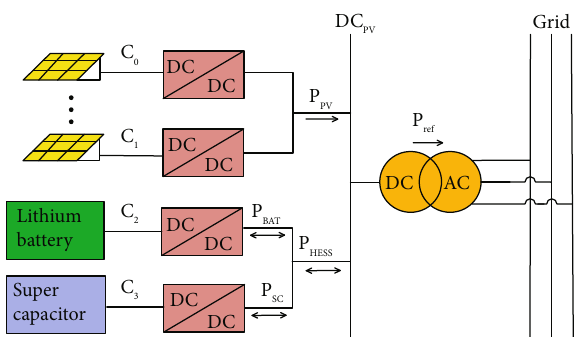
Figure 1: Structure of optical storage